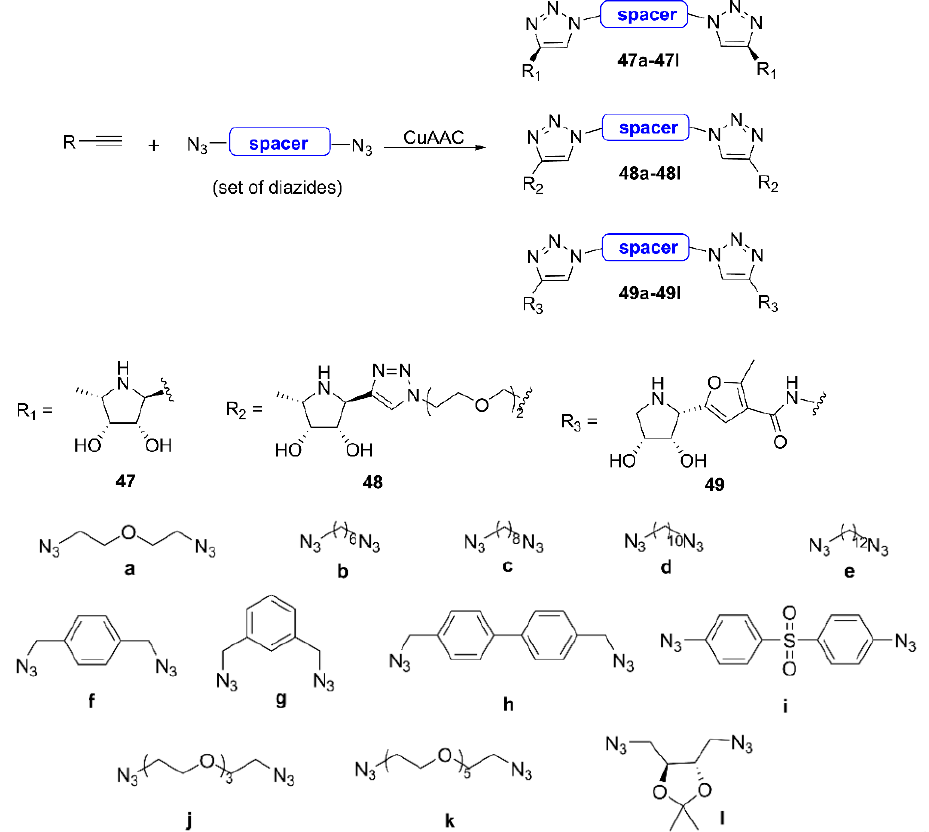
Figure 6. Generation of libraries of dimeric iminosugars ( 47a – l , 48a – l , and 49a – l ) for in situ screen- ing.